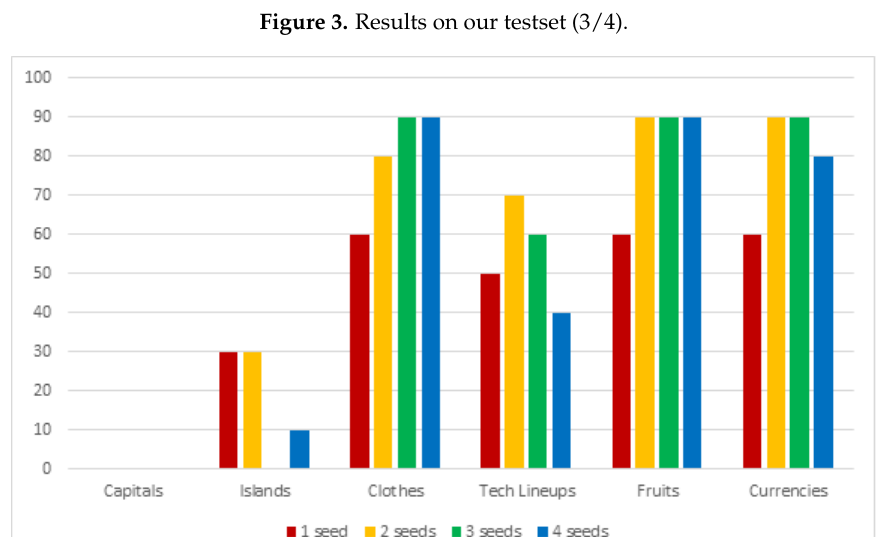
Figure 3. Results on our testset (3/4).